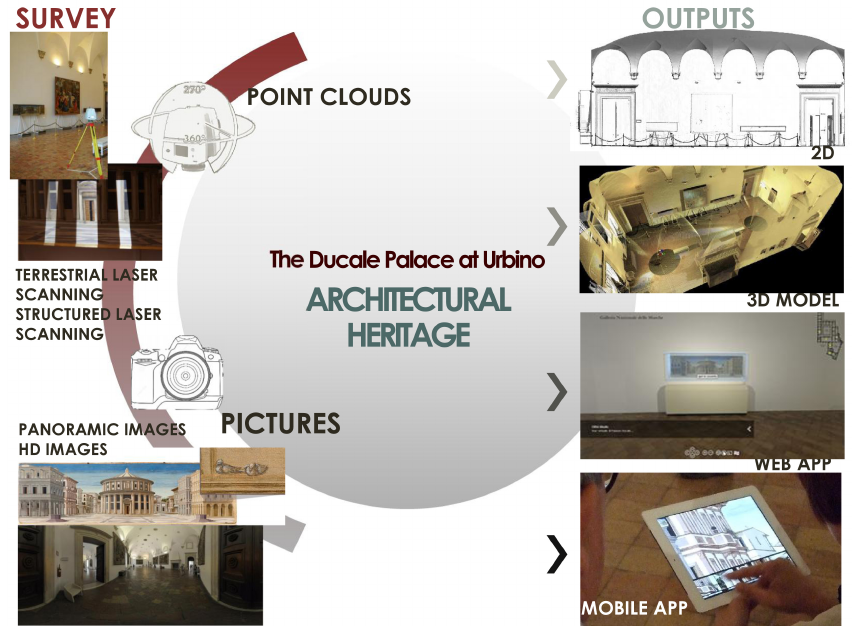
Figure 4: Workflow from acquisition to outputs in AAH fields: the Palazzo Ducale at Urbino demonstrator. (cid:15) real time (or quasi real time) monitoring of the evidences /